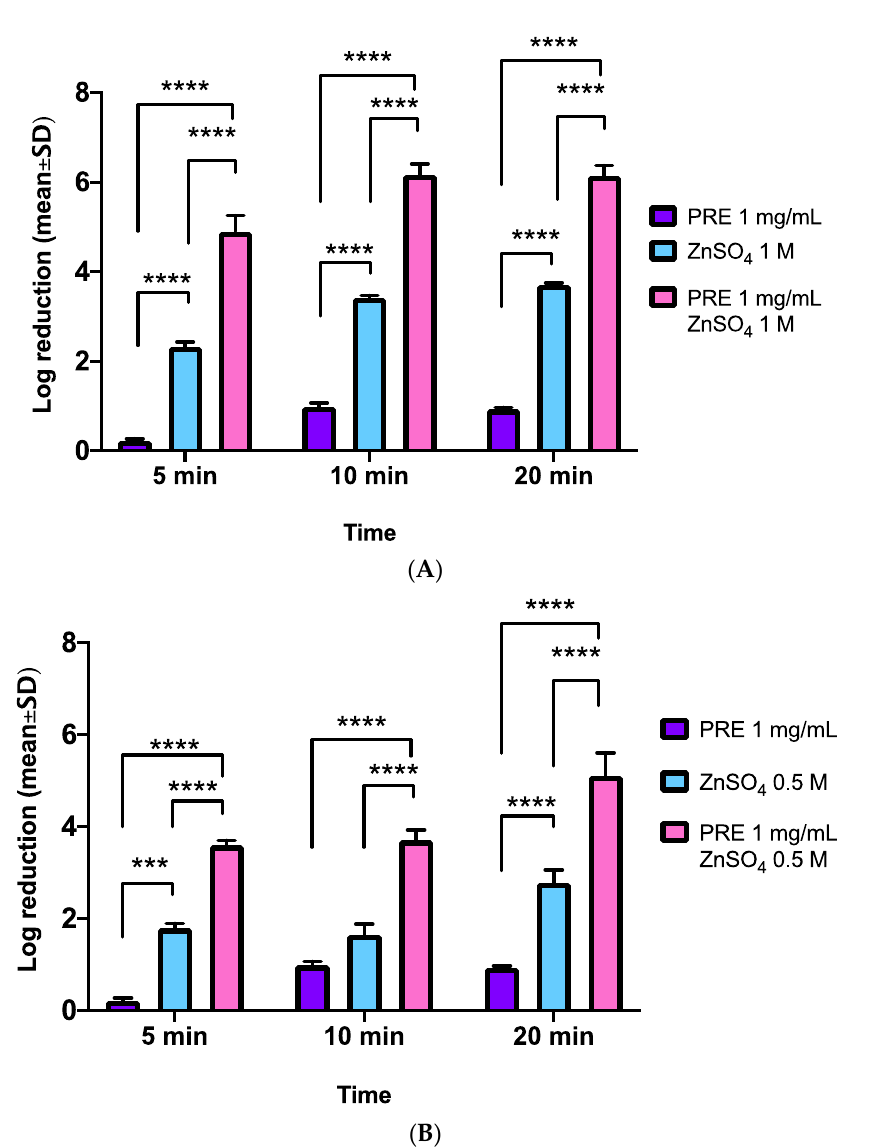
Figure 4. Log 10 reduction of E. coli CFUs at incubation times of 5 min, 10 min and 20 min ( n = 9 ± SD). ( A ) PRE (1 mg/mL) and Zn (II) (0.5 M) alone and in combination. ( B ) PRE (1 mg/mL) and Zn (II) (1 M) alone and in combination. Tukey’s multiple comparison post-hoc test show statistically significant differences (*** p ≤ 0.001, **** p ≤ 0.0001).